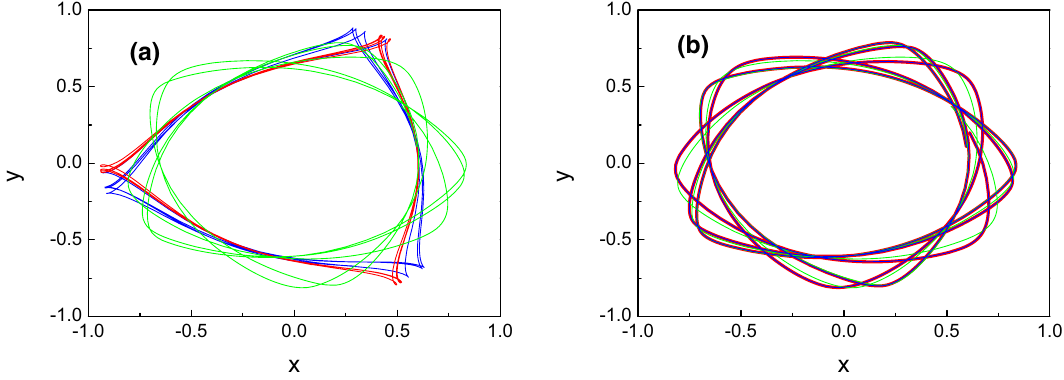
Fig. 4 Orbit 3 in Newtonian case (green curve), 1PN truncated system (red curve), and the exact system (blue curve) with: a c = 10; b c = 100